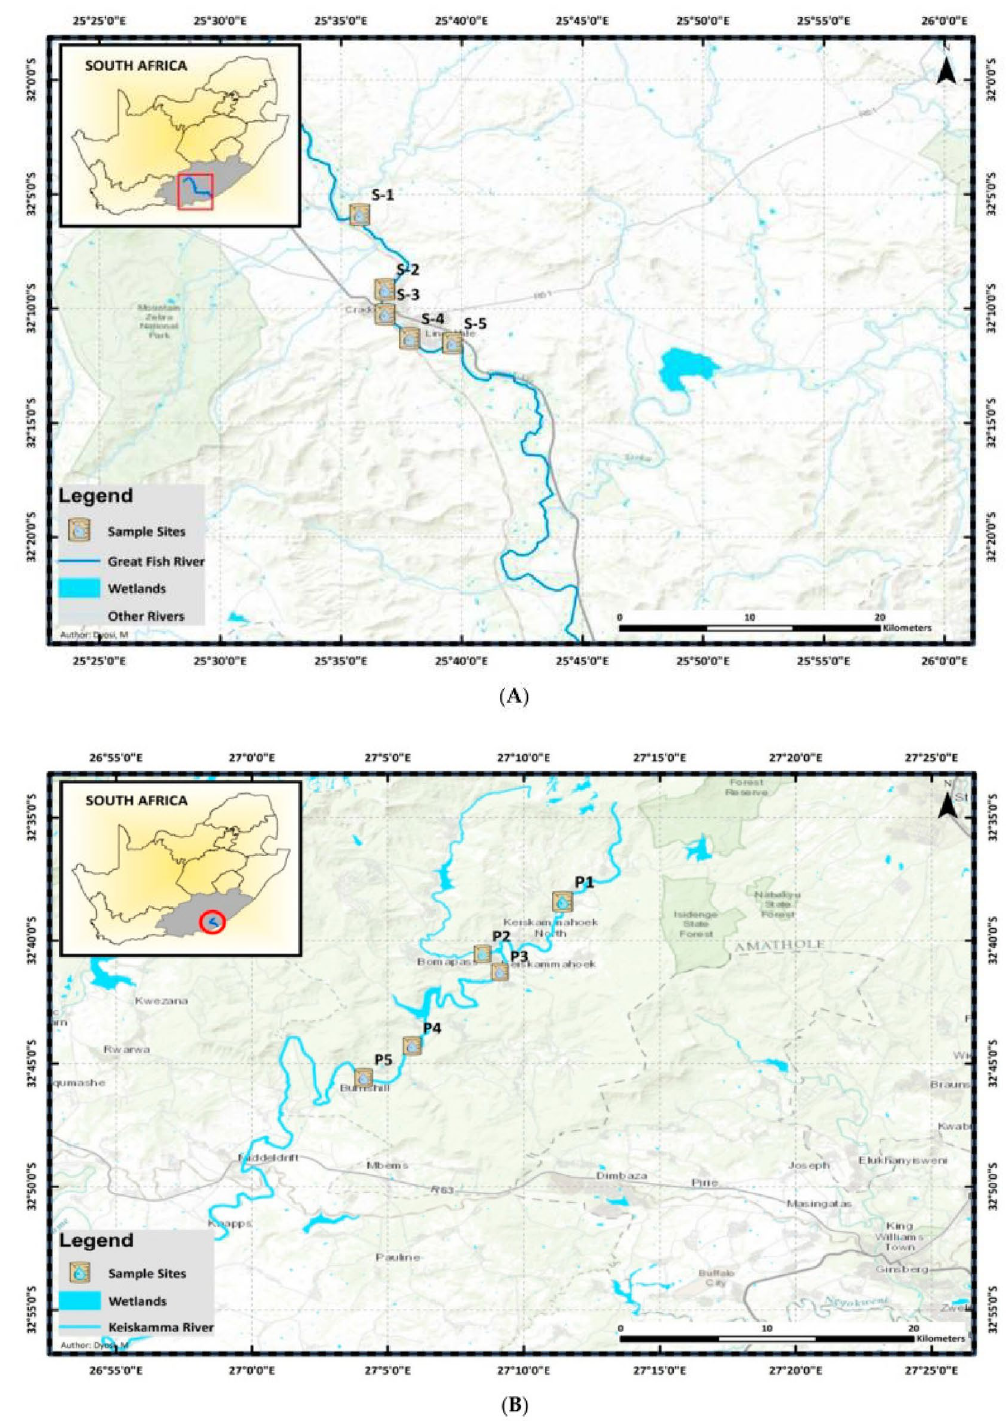
Figure 1. ( A ) Map of Great Fish River showing the sampling points. ( B ) Map of Keiskamma River showing the sampling points ( C ) Map of Tyhume River showing the sampling points [The map has been published in